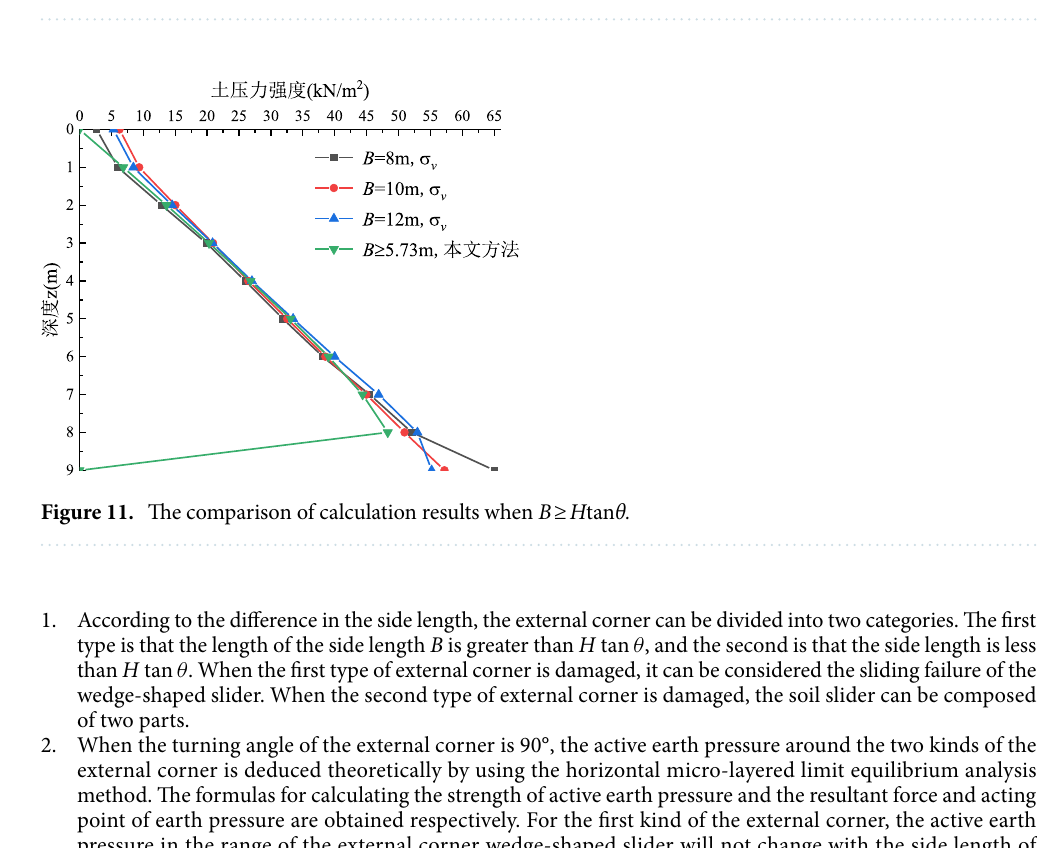
Figure 10. The comparison of calculation results when B < H tan θ.